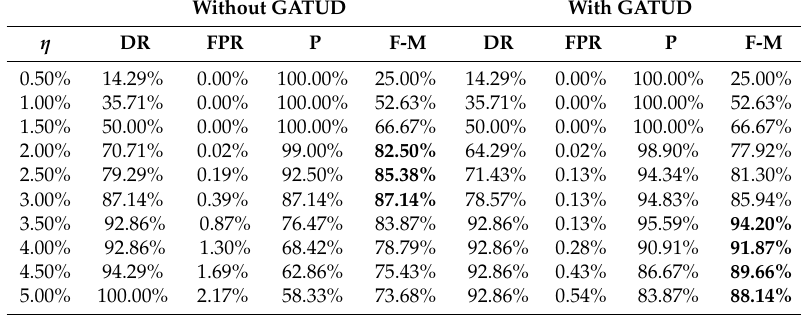
Table 2. The separation accuracy of abnormal observations with/without GATUD on DUWWTP. Without GATUD With GATUD